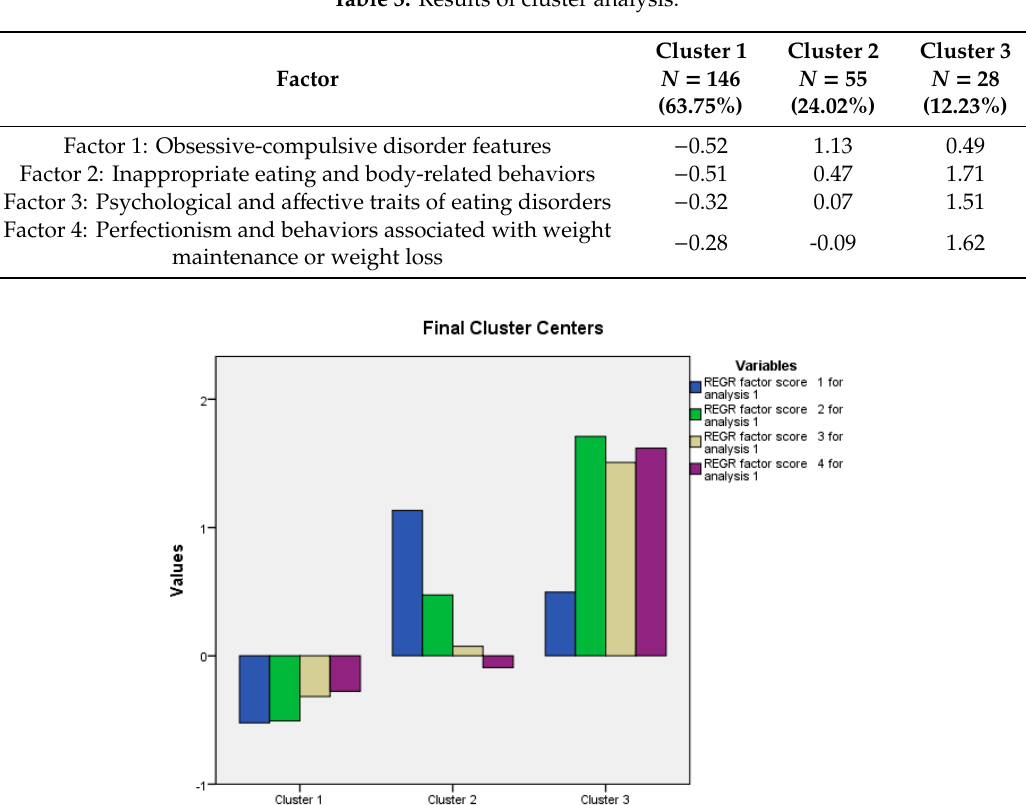
TestAbsence of ON ( N = Variable p